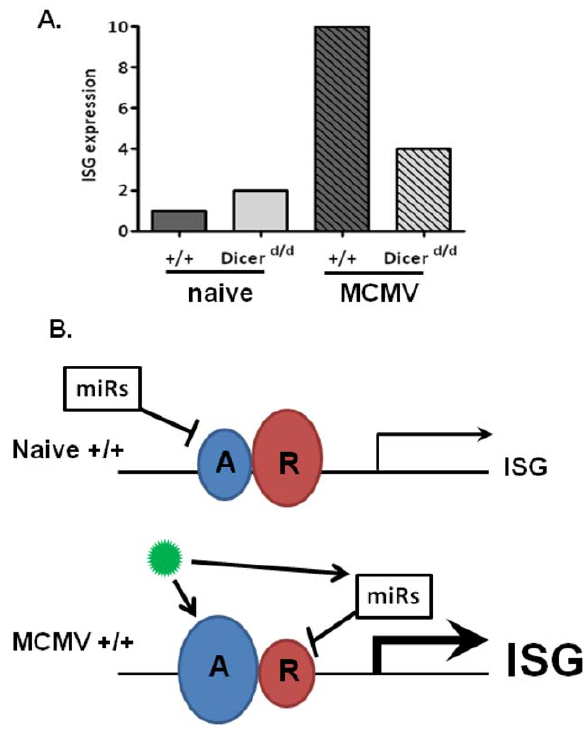
Figure 8. Model for miR-dependent control of IFN-regulated genes. A. Schematic representation of our macroarray data. Interferon- stimulated genes (ISG) expression is indicated for controls ( + / + , dark grey) and Dicer d/d (light grey) cells in naı¨ve or MCMV-stimulated conditions. B. In naı¨ve control ( + / + ) cells, repression of ISGs is secured by miRNA-mediated repression exerted on transcriptional activators (in blue); on the contrary, rapid induction of ISGs upon virus (depicted in green) infection is permitted by MCMV-induced miRNA-mediated release of repressors (in red) along with virally-induced transcriptional induction of activators.